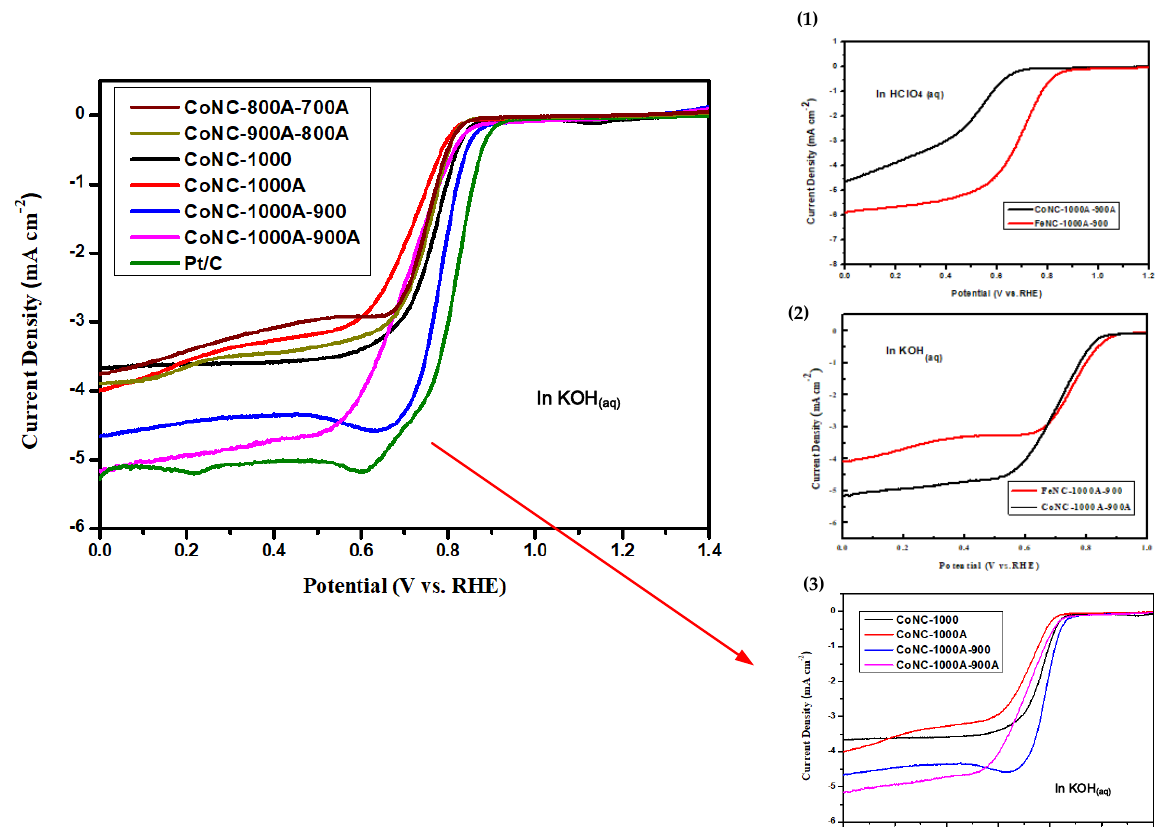
Figure 8. LSV curves of various Co-N-C catalysts. LSV curves of Fe-N-C and Co-N-C in ( 1 ) HClO 4 , ( 2 ) KOH, and ( 3 ) Co-N-C catalysts at 1000 °C.